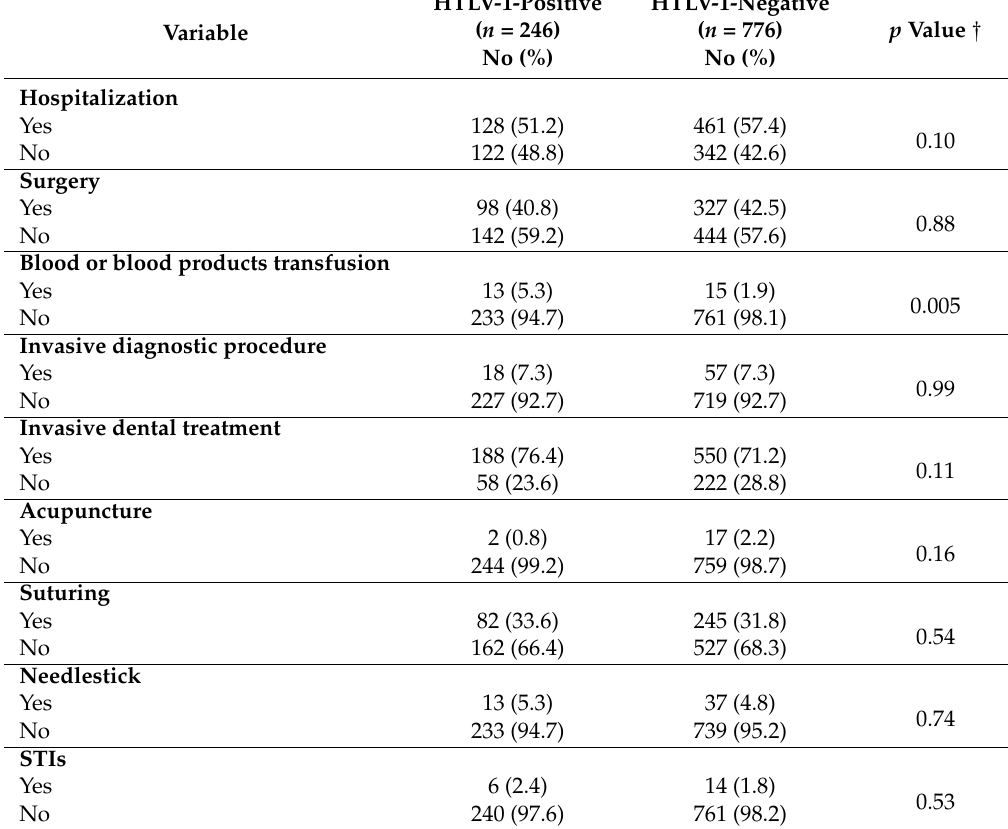
Table 3. Medical histories of blood donors associated with HTLV-1